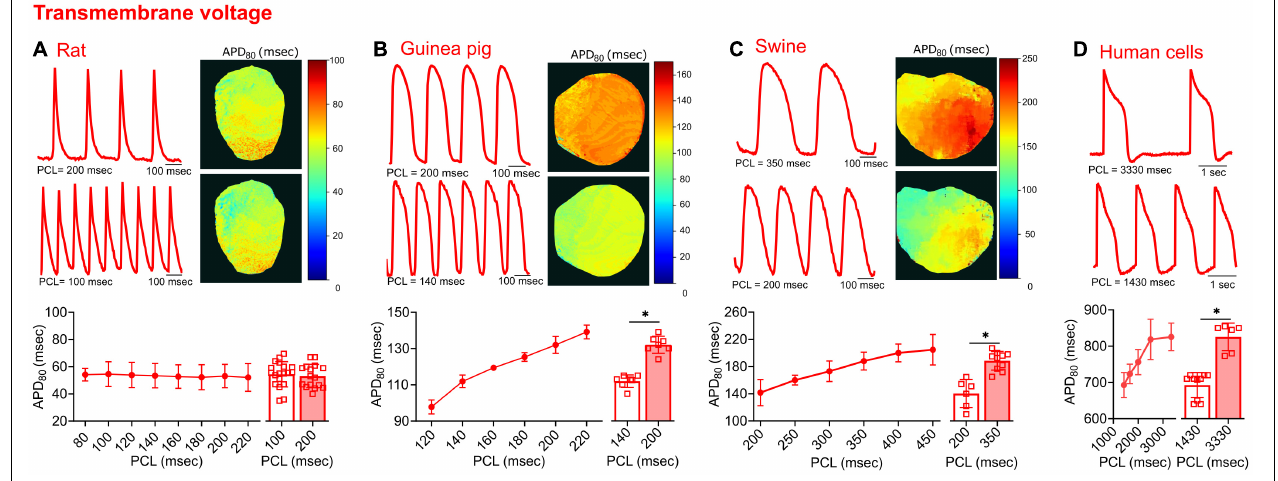
FIGURE 4 | Transmembrane voltage measurements acquired from four different species. (A) Representative signals and APD 80 maps from a rat heart paced at 200 and 100 ms PCL (top). Compiled restitution curve of APD 80 , in response to dynamic epicardial pacing (bottom left, n = 13–20 independent heart experiments). No change in APD 80 was observed between 100 ms and 200 ms PCL (bottom right, n = 16–19 independent heart experiments). (B) Representative signals and APD 80 maps from a guinea pig heart paced at 200 and 140 ms PCL (top). Compiled restitution curve of APD 80 , in response to dynamic epicardial pacing (bottom left, n = 5–7 independent heart experiments). Longer APD 80 values observed at slower rates (200 vs. 140 ms PCL, n = 7 independent heart experiments). (C) Representative signals and APD 80 maps from a swine heart paced at 350 and 200 ms PCL (top). Compiled restitution curve of APD 80 , in response to dynamic epicardial pacing (bottom left, n = 4–10 independent heart experiments). Longer APD 80 values observed at slower rates (350 vs. 200 ms PCL, n = 6–10 independent heart experiments). (D) Representative signals from hiPSC-CM paced at 3330 and 1430 ms PCL (top). Compiled restitution curve of APD 80 , in response to field potential stimulation (bottom left, n = 6–15 independent cell preparations). Longer APD 80 values observed at slower rates (3330 vs. 1430 ms PCL, n = 6–10 independent cell preparations). Values reported as mean ± SD. * p < 0.05, as determined by an unpaired Student’s t -test (two-tailed).